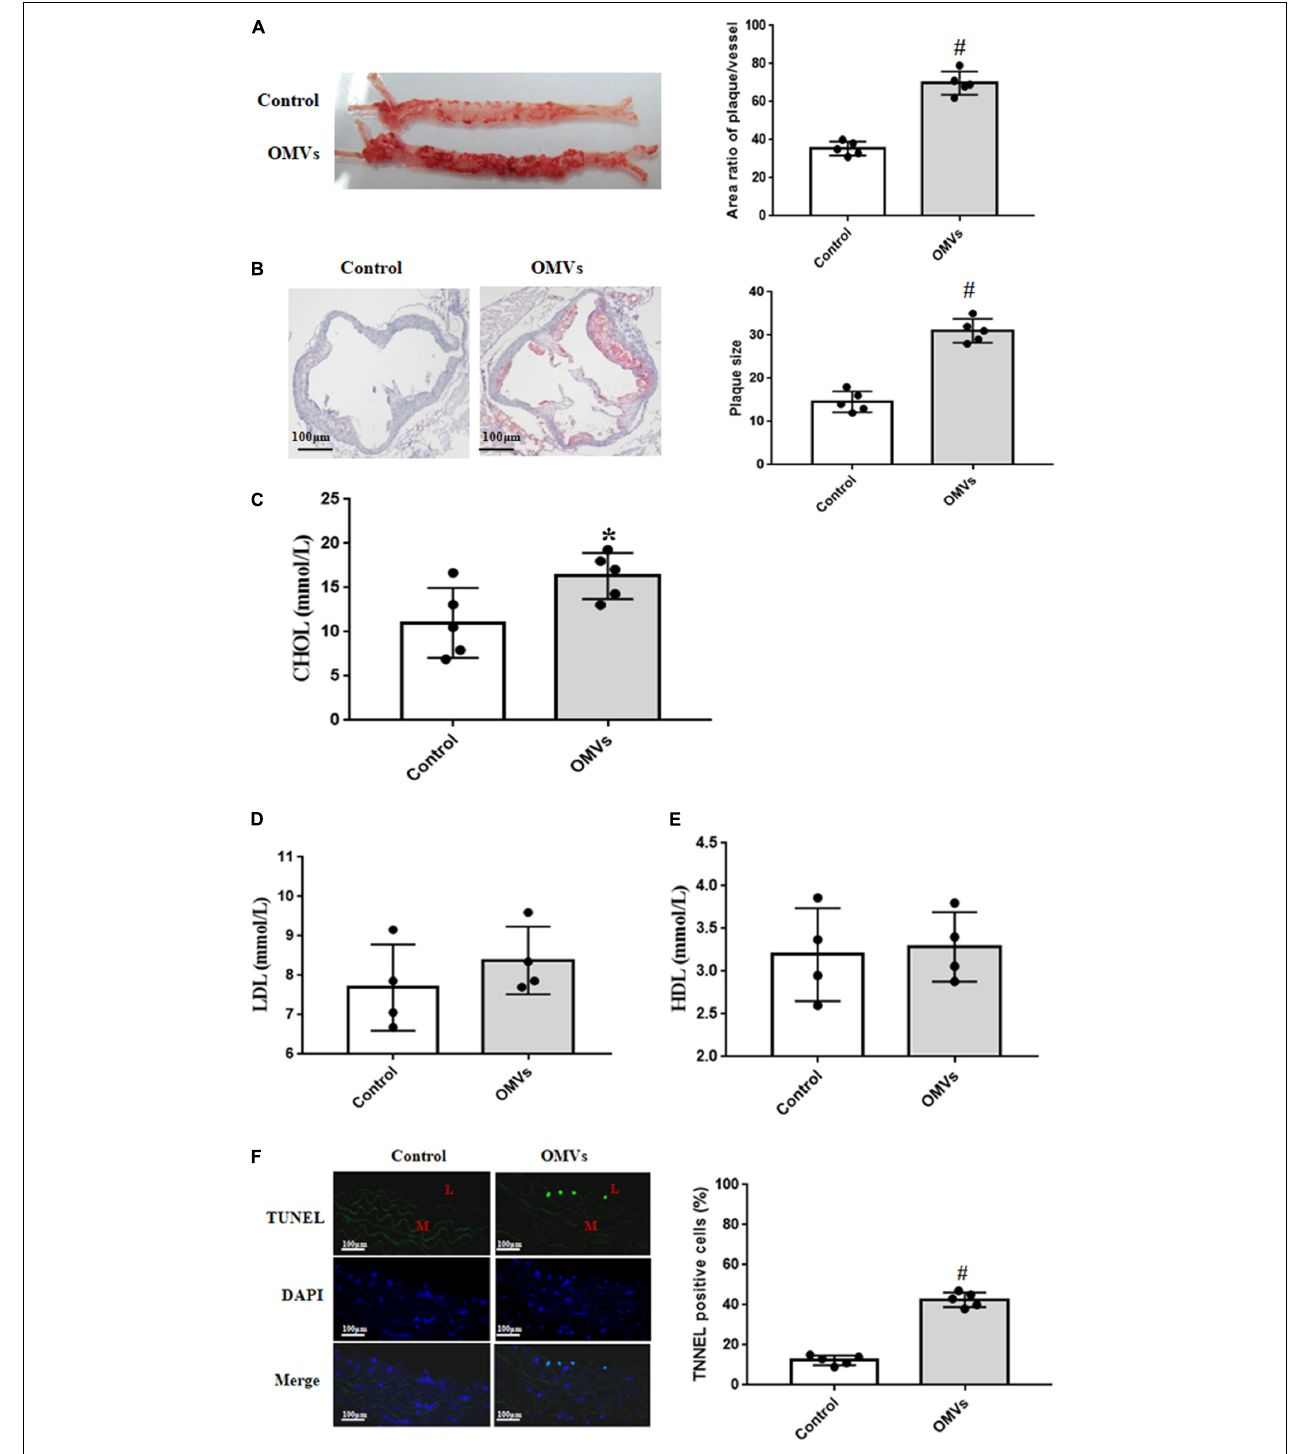
FIGURE 2 | H. pylori -derived OMVs accelerate atherosclerosis plaque formation in ApoE − / − mice. (A) Continuous atherosclerosis plaques were measured by Oil Red O staining in ApoE − / − mice treated with H. pylori -derived OMVs ( n = 5, # P < 0.01 vs. control). (B) Cross-section histological analysis were determined by HE staining in ApoE − / − mice treated with H. pylori -derived OMVs ( n = 5, # P < 0.01 vs. control). (C–E) The levels of serum lipids, including cholesterol ( C , CHOL), low density lipoprotein cholesterol ( D , LDL), high density lipoprotein cholesterol ( E , HDL), were determined by ELISA in ApoE − / − mice treated with H. pylori -derived OMVs ( n = 4 or 5, * P < 0.05 vs. control). (F) Apoptosis were measured by TUNEL staining in arteries from ApoE − / − and control mice. Magnification is × 20; blue, cell nuclei (DAPI staining); green, TUNEL staining; L, lumen; M, media ( n = 5, # P < 0.01 vs. control).